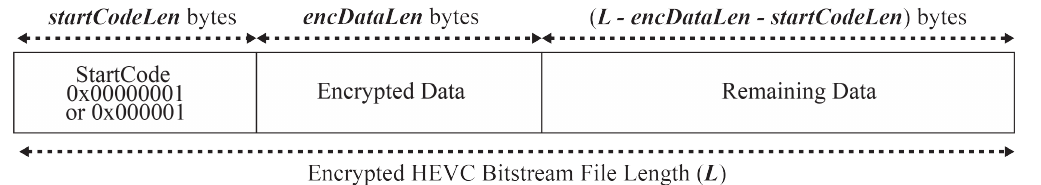
Figure 10. Output encrypted HEVC stream—Type 1.